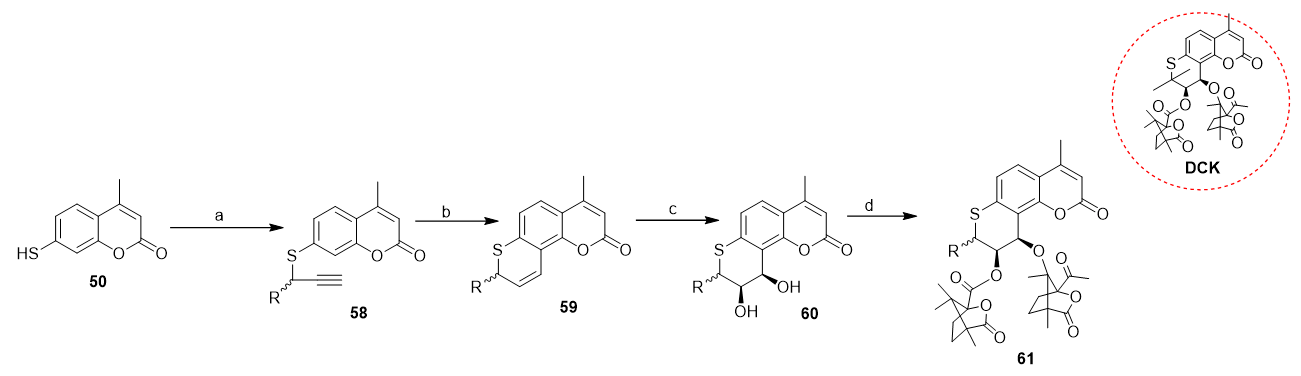
Scheme 18. Synthesis of bacterial enzyme DNA gyrase inhibitor. Reagents and conditions: (a)